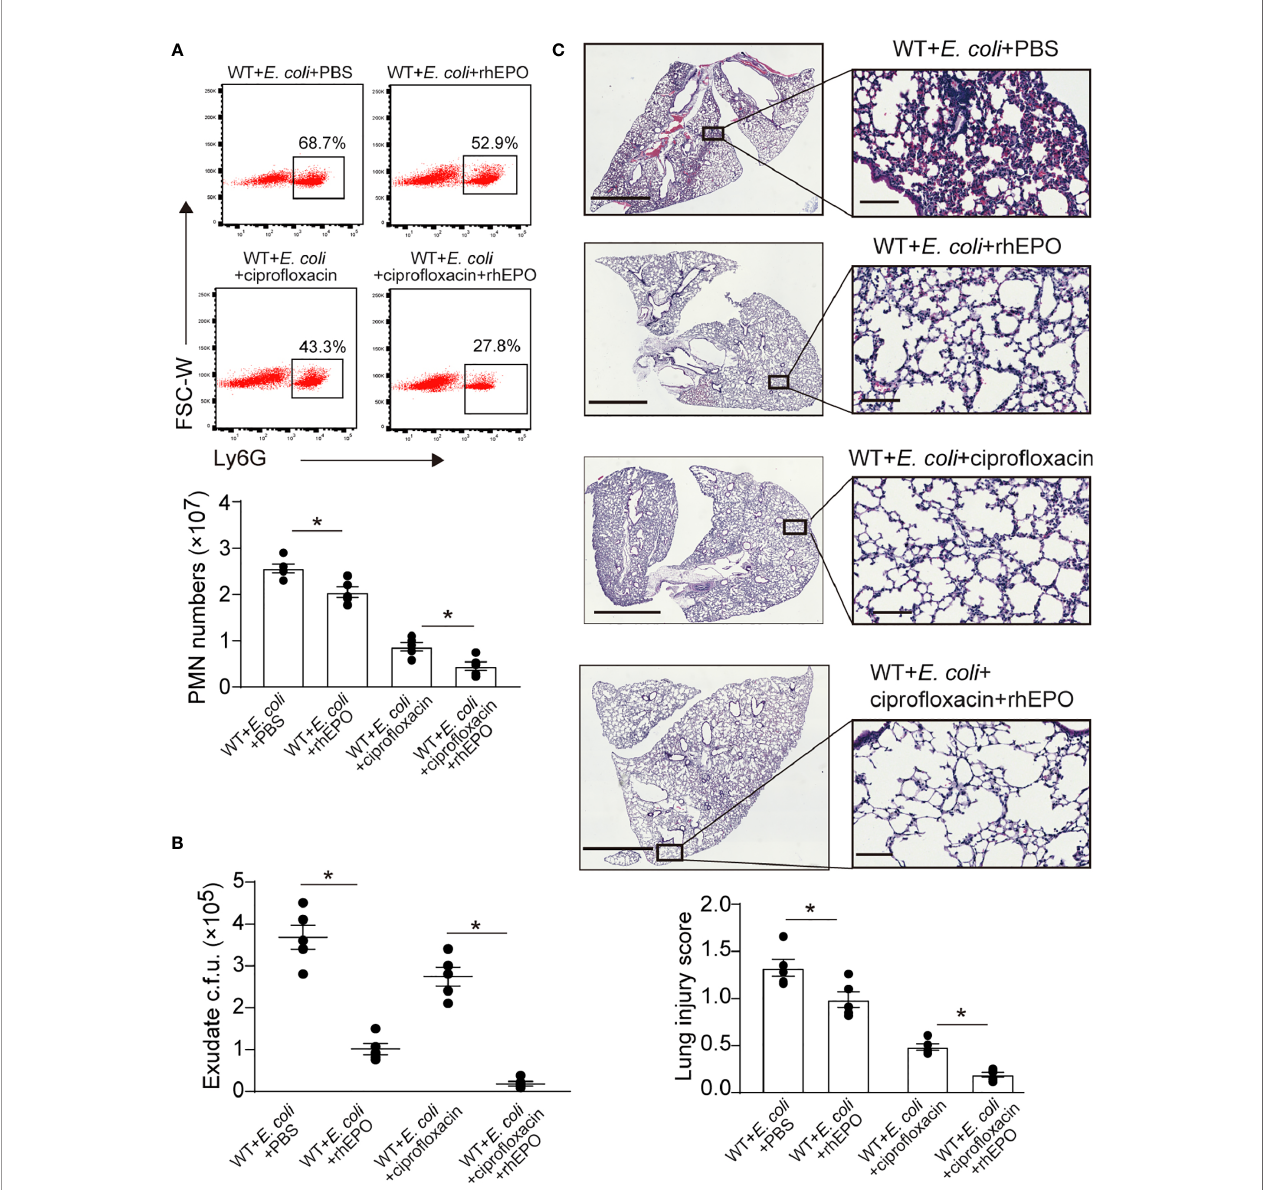
FIGURE 6 | EPO promotes bacterial clearance and enhances cipro fl oxacin actions in resolution-delayed E. coli -initiated infections. WT mice were inoculated with E. coli (5 × 10 6 c.f.u.) by intraperitoneal injection. After 2 hrs, mice were treated with rhEPO (5,000 IU/kg), cipro fl oxacin (12.5 mg/kg), cipro fl oxacin (12.5 mg/kg) plus rhEPO (5,000 IU/kg) or PBS. After 24 hrs, mice were sacri fi ced (n = 5). (A) : Percentage and cell numbers of peritoneal PMN cells. (B) : Bacterial titers of peritoneal lavage fl uids. (C) : Histopathology in lungs (2 mm for left bars,100 m M for right bars). The lung injury score was assessed as described in Materials and Methods. Data are representative of at least two independent experiments. Results were expressed as mean ± SEM. * P < 0.05. Statistics: one-way ANOVA with Tukey ’ s post hoc test for multiple comparisons (A – C)